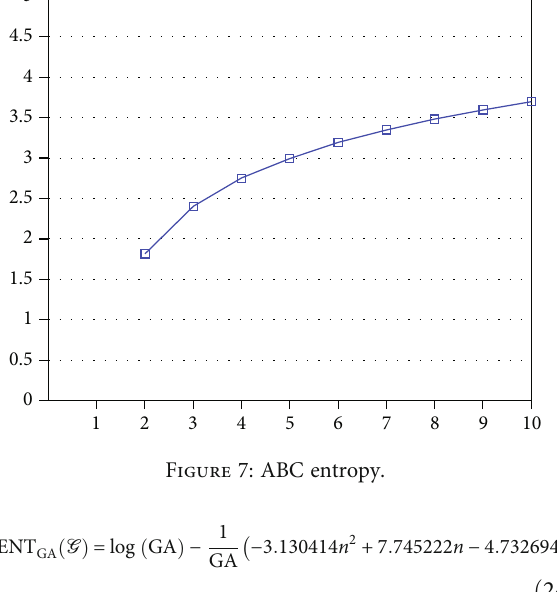
Figure 7: ABC entropy.